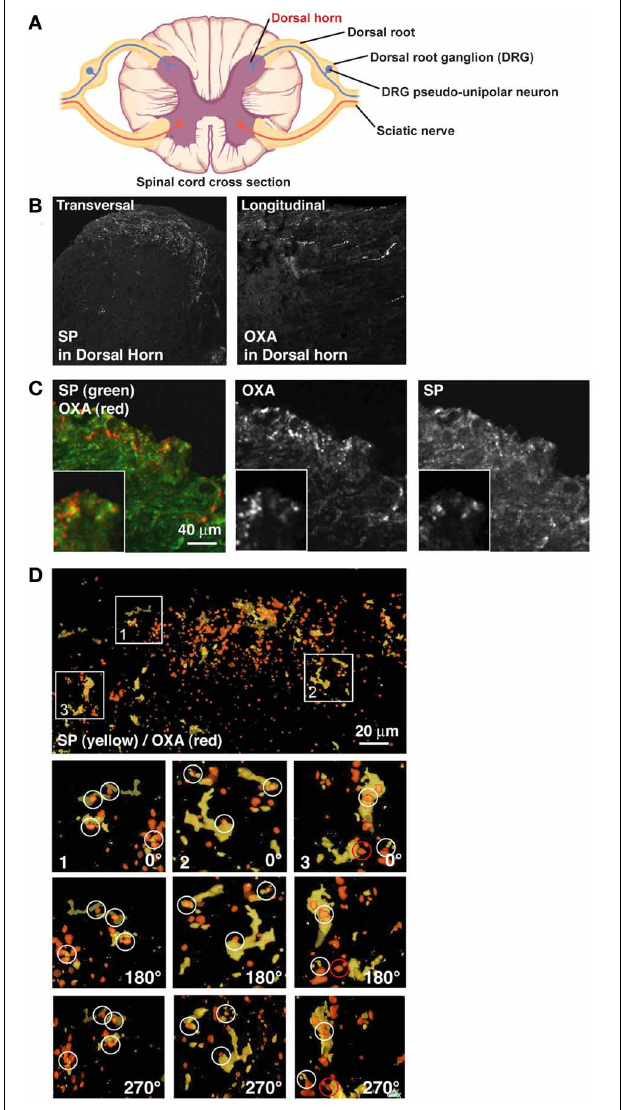
FIGURE 1 | OXA hypothalamic fibers appose with SP positive DRG fibers in the dorsal horn. (A) Scheme of a spinal cord cross section (modified from OpenStax College PNS course). Dorsal horn, site of analyses presented below, is indicated in red. (B) Left panel: transversal section of spinal cord stained for SP. SP decorates lamina I and II of the dorsal horn. Right panel: longitudinal section of spinal cord stained for OXA. OXA is present in lamina I and II of the dorsal horn. (C) Transversal section of lamina I and II of the dorsal horn stained for OXA (red) and SP (green). (D) While some colocalization was visible in B, juxtaposition became clear only after a 3D reconstruction (SP in yellow and OXA in red). In inserts 1, 2, and 3, SP terminals in the section were colocalized or in contact with OXA terminals. Inserts were rotated by 180 ◦ (first panel under the insert) and by 270 ◦ (second panel under the insert). White circles show apposition of SP and OXA and a red circle shows an example of false